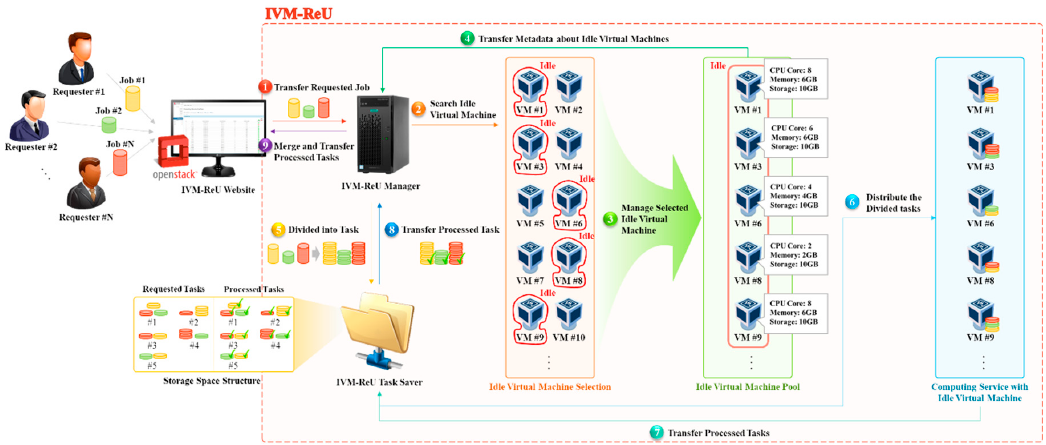
Figure 1. Basic operation diagram of idle virtual machine–resource utilization (IVM–ReU).